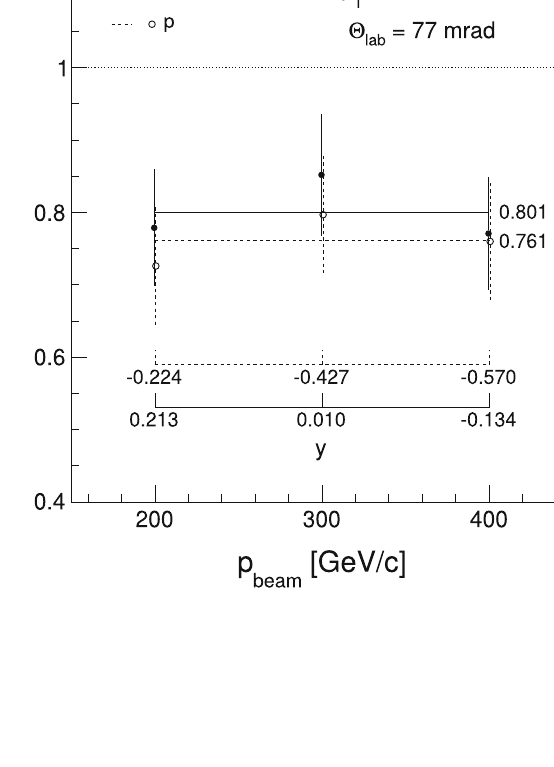
Fig. 54 Ratio of data from [34] and global interpolation at p T = 0.77 GeV/c at 200, 300 and 400 GeV/c beam momentum indicating the corresponding rapidity values